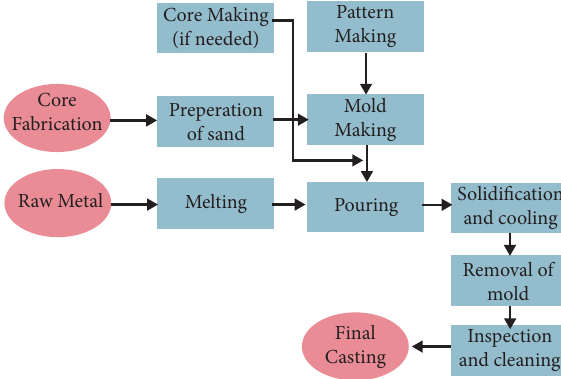
Figure 2: Sand casting process.